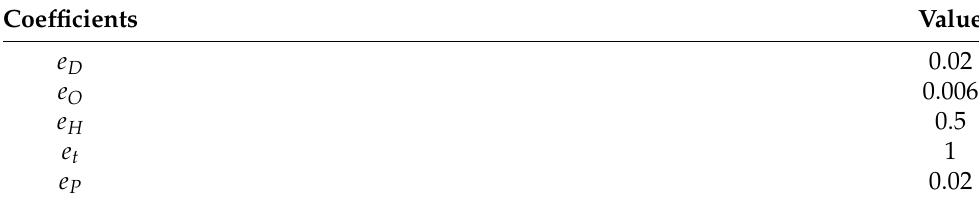
Table 1. Coefficients of reward